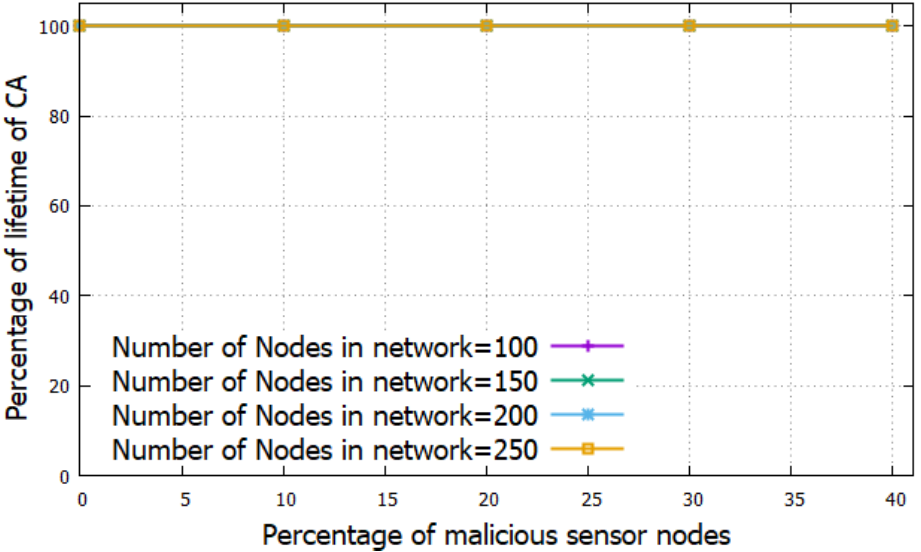
Figure 8. The lifetime of the CA as a function of the percentage of malicious sensor nodes.